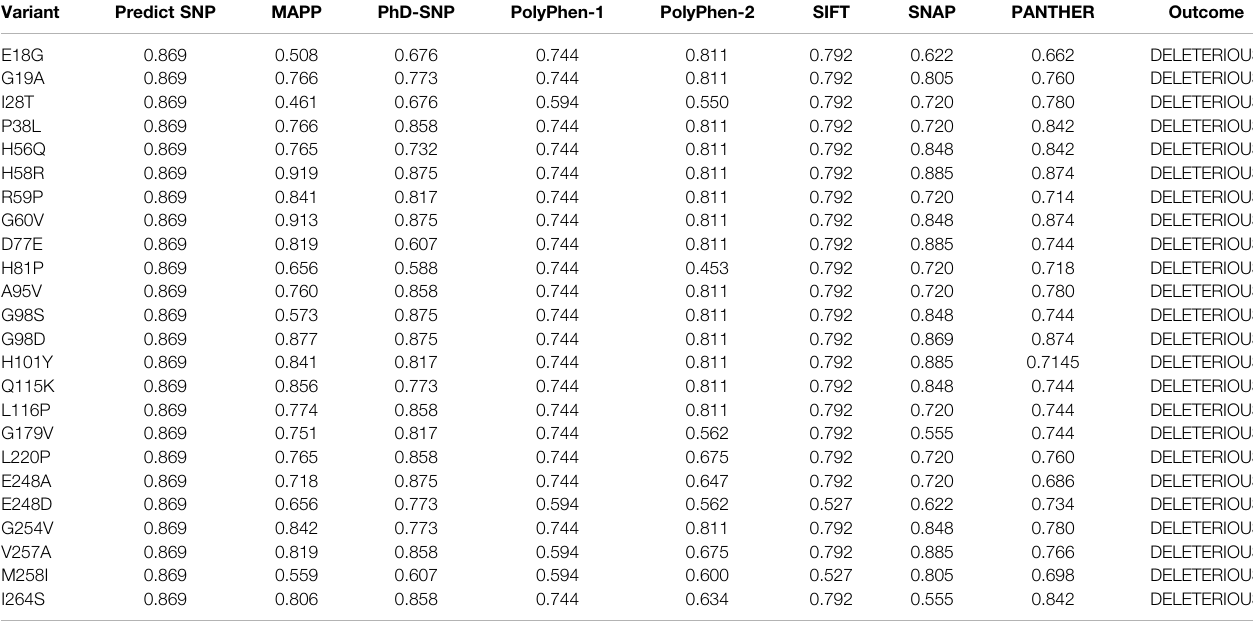
TABLE 1 | Processing of 119 missense variants bydifferent servers predicted 24mutations to be deleterious collectively. The predicted score by each server is also shown. Variant Predict SNP